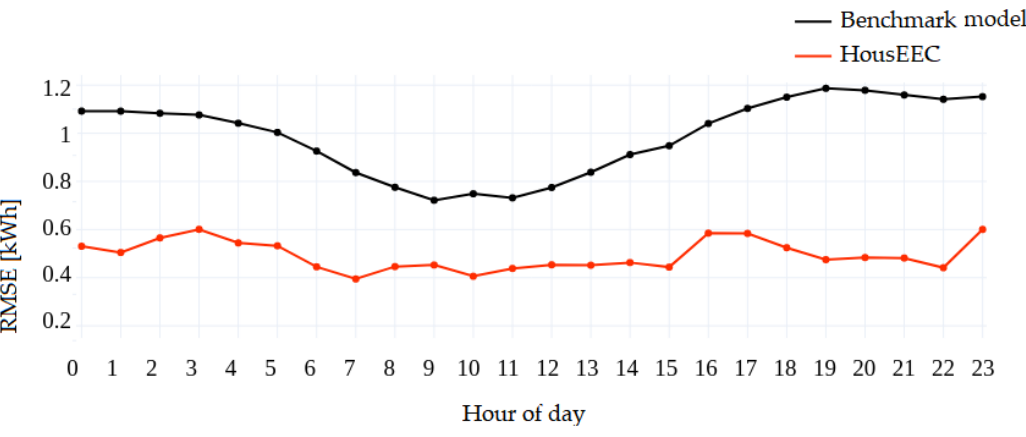
Figure 8. Root-mean-square error (RMSE) for each hour of the day.